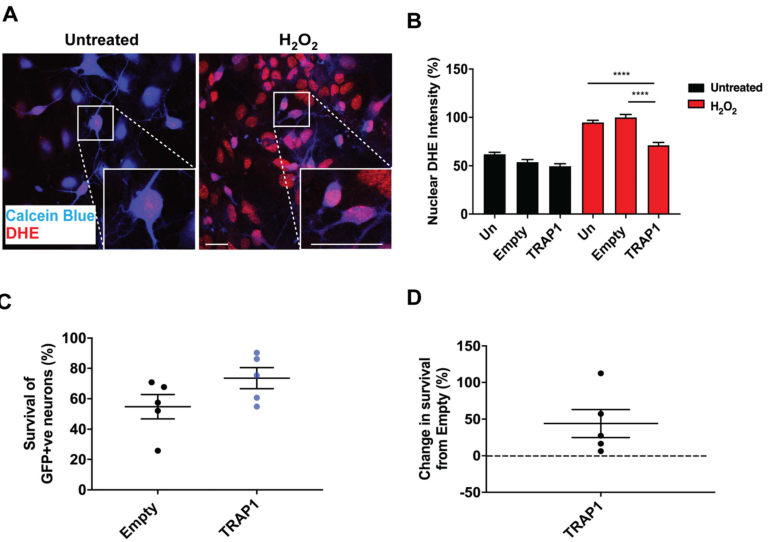
Figure 2. TRAP1 overexpression in motor neurons rescues H 2 O 2 -induced ROS production and neuronal death. ( A ) Representative images of DHE and calcein blue fluorescence in primary motor neurons exposed to 500 µ m H 2 O 2 for 30 min. ( B ) Quantification of DHE intensity measurements from lentivirally treated motor neuron cultures exposed to 500 µ m H 2 O 2 for 30 min. n = 3–4, 106–167 neurons. Quantification of percentage survival compared to untransduced cultures ( C ) and percentage change in survival from cultures treated with empty lentiviral construct ( D ) in GFP–positive neurons exposed to 100 µ m H 2 O 2 for 24 h . n = 5. **** p ≤